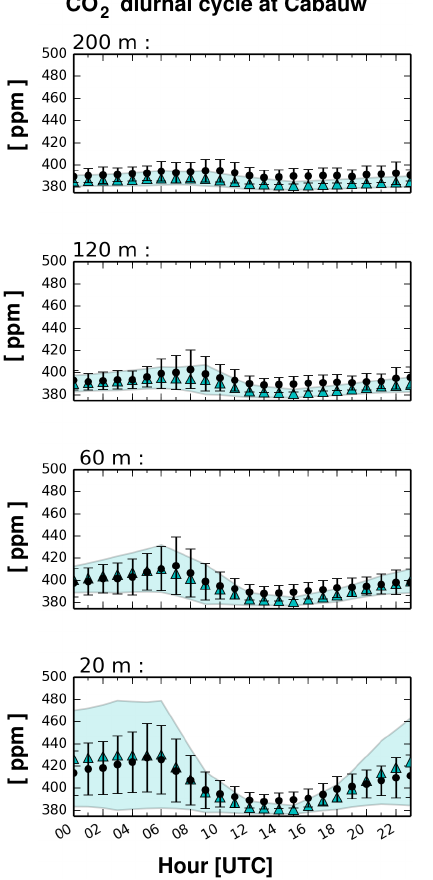
Figure 11. Mean diurnal cycle of CO 2 dry molar fraction [ppm] at the ICOS site at Cabauw (Netherlands) from measurements (dark circles) and hindcast (blue triangles) in September 2011 at several sampling heights. The standard deviation of observations and hind- cast are shown as black bars and blue shading respectively.